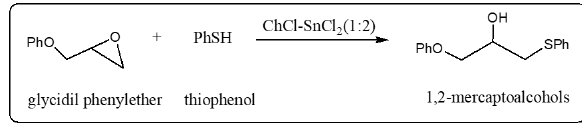
Figure 1: Ring opening of epoxides by using ChCl-SnCl